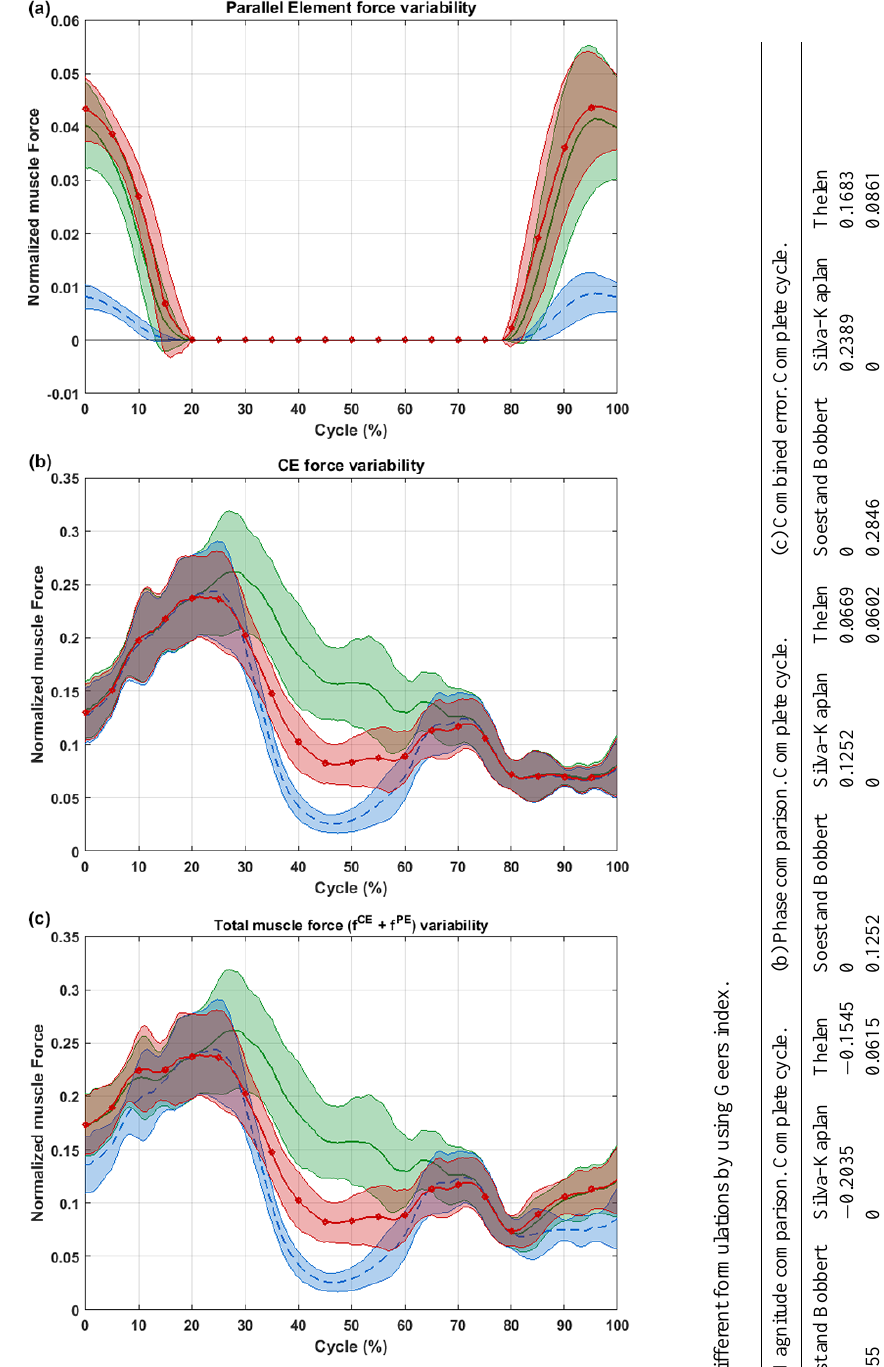
Figure 6. Normalized muscle forces of biceps brachii in the flexo– extension movement. Mean ± standard deviation. (a) PE force. (b) CE force. (c) CE + PE force. Green solid line: Van Soest and Bobbert. Red dotted line: Thelen. Blue dashed line: Silva– Kaplan. The normalized muscle forces were obtained as the ratio F PE/CE /F M 0